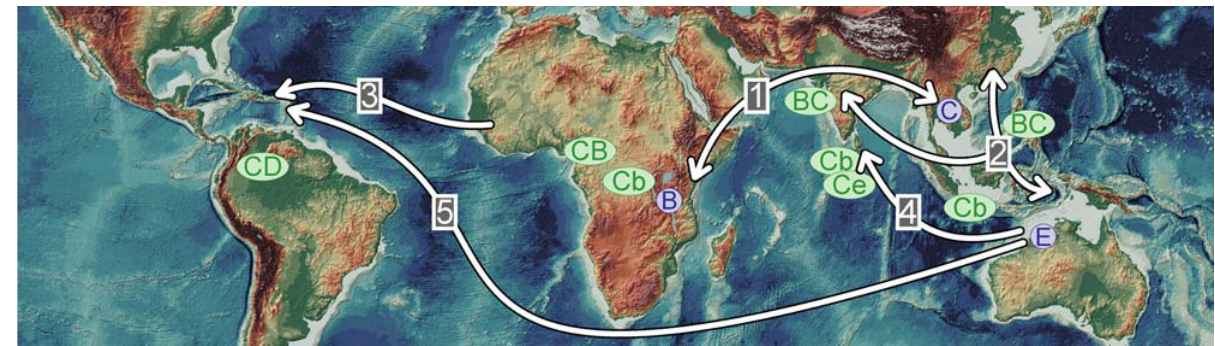
Figure 2. The ‘ O.officinalis diploid-tetraploid complex’ in relation to major routes of great navigation. Distribution map of the genomes distinguished in the ‘ O. officinalis complex’, as detailed in Table 2. The three spontaneous diploid genomes (B, C, and E) and the derived genomes or subgenomes are figured in blue and yellow respectively. Arrows indicate presumed routes of human dispersion of Oryza across natural geographic barriers exchanges: exchange of goods during many centuries between Asia and Africa (1), and with insular Southeast Asia (2) through navigation; the ‘‘Middle Passage’’ during the triangular trade which involved one way slave trade from Africa to the Americas (3); introduction of O. australiensis to Sri Lanka (4) as a curio after the discovery of Australia by Europeans (but possibly earlier); introduction of O. australiensis to Caribbean rice fields (5) as a curio during the 17 th century from Australia (possibly via Sri Lanka). World map after Calmant et al. [87].